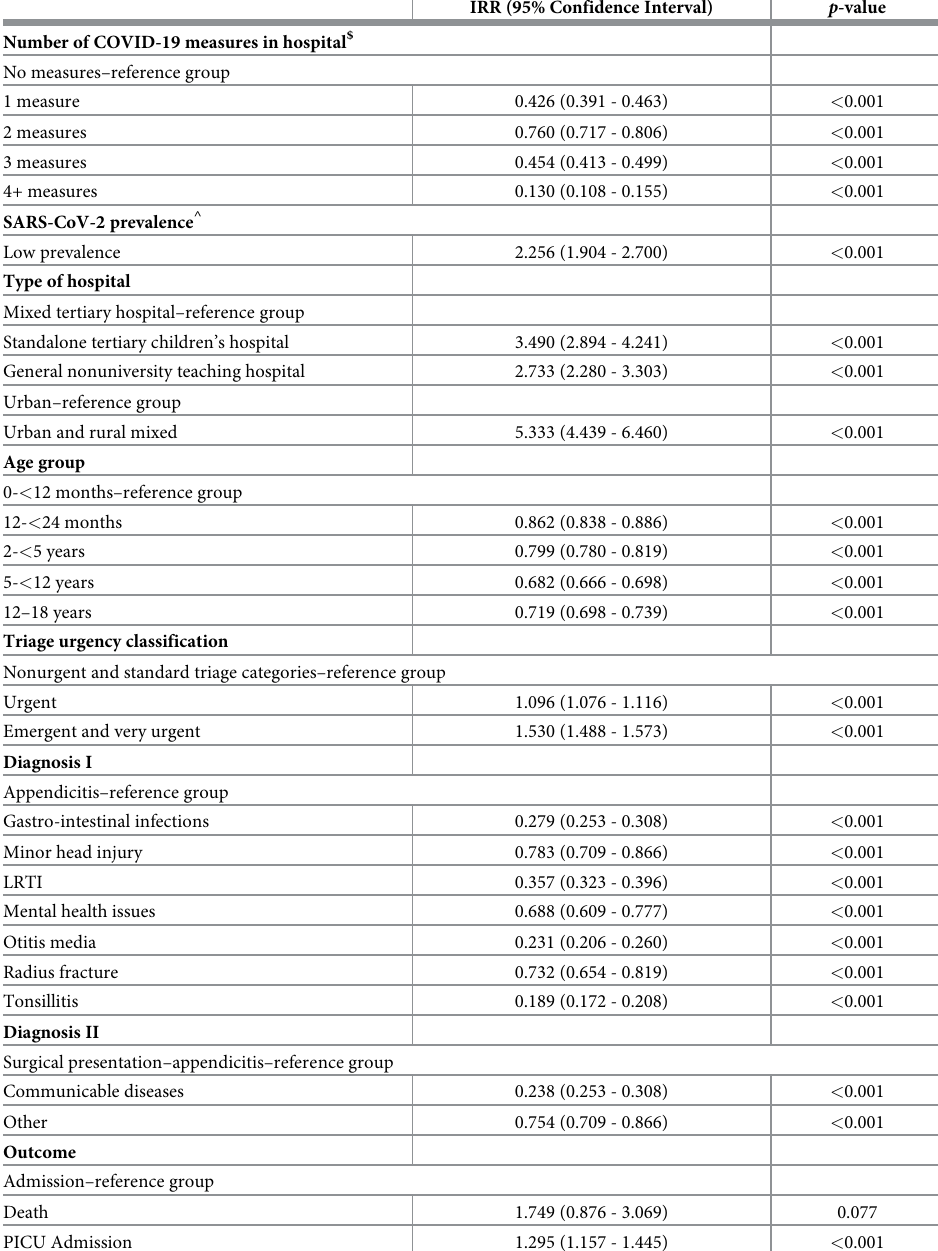
Table 2. Poisson regression models for ED